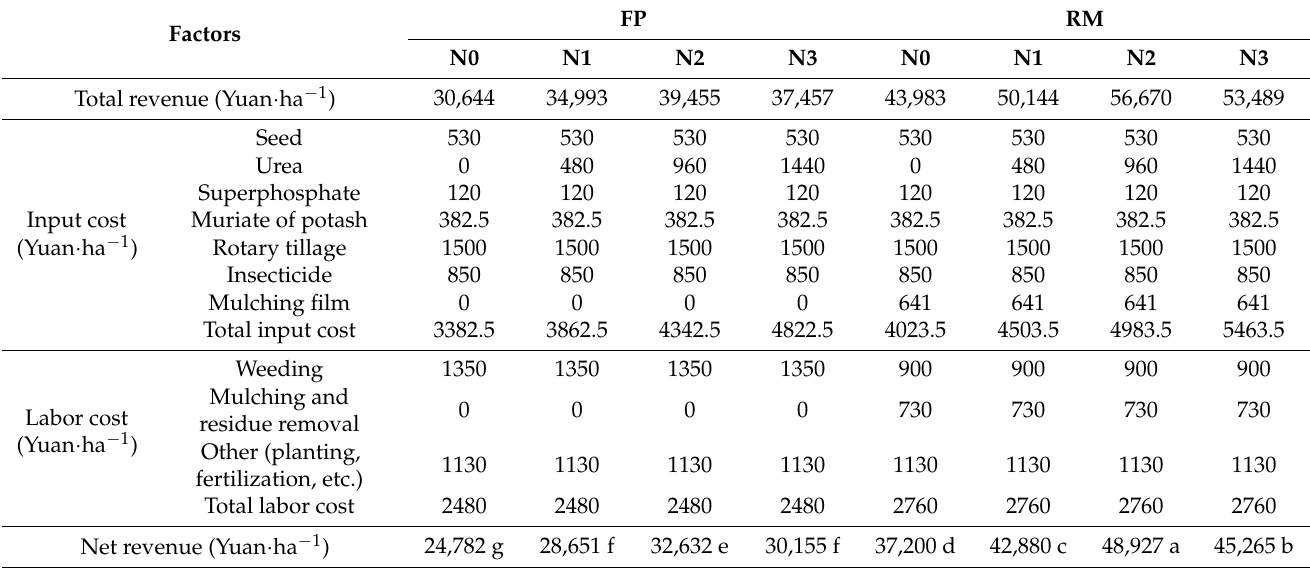
Table 6. Impact of planting pattern and nitrogen level on alfalfa economic